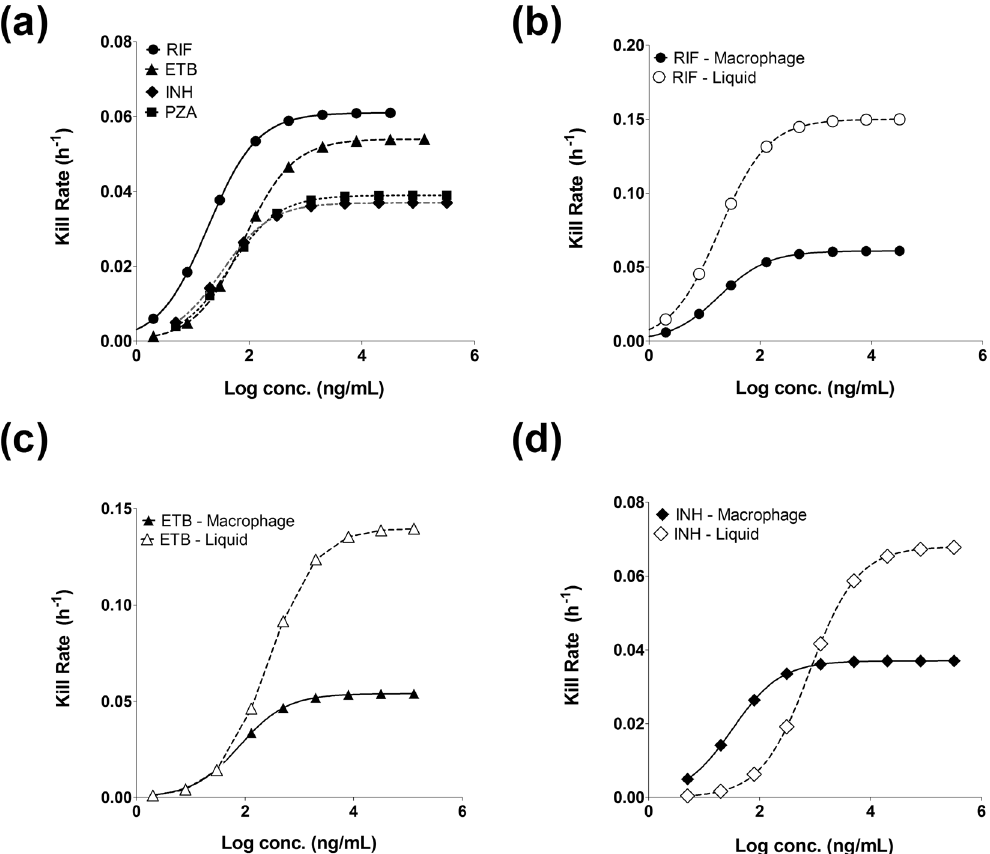
Figure 3. Intracellular (macrophage) and extracellular M. tuberculosis time-kill relationships. ( a ) Simulated concentration–kill rate relationship based on parameters generated from analysing intracellular Mtb kill curves for RIF (black circles), ETB (black triangles), INH (black diamonds) and PZA (black squares). ( b ) shows the concentration–kill relationship for RIF intracellular (black circles) and extracellular (open circles). ( c ) show the concentration–kill relationship of ETB intracellularly (black triangles) and extracellularly (open triangles) and ( d ) for the concentration–kill relationship of INH intracellularly (black diamonds) and extracellularly (open